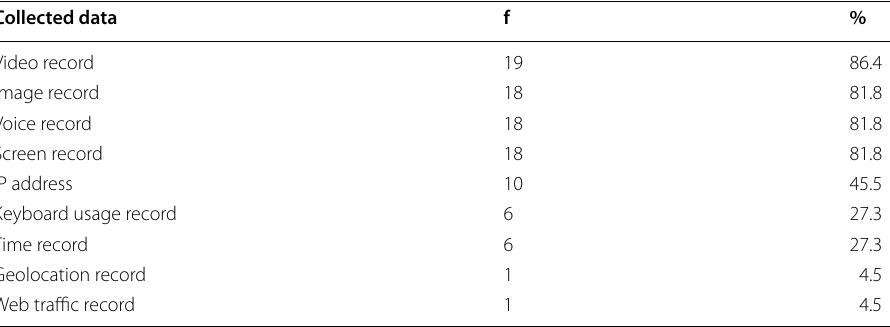
Table 7 Data analyzed by online assessment systems Collected